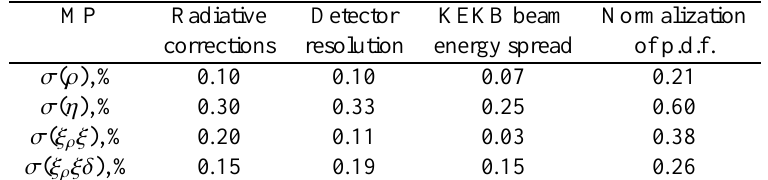
Table 1. Systematic uncertainties of MP. Values are shown in units of percent (i.e. absolute deviation of the MP is multiplied by